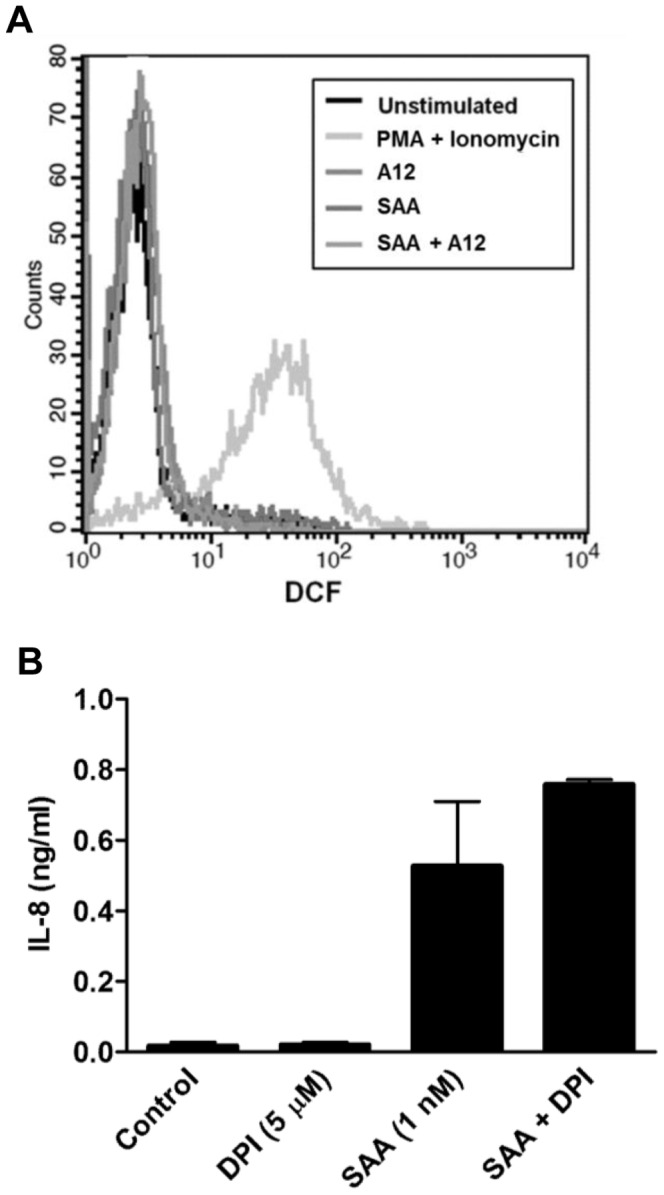
SAA at 1 nM had no effect on intracellular ROS levels.(A) Histogram from flow cytometric analysis of intracellular ROS levels in PBMC. The black line represents unstimulated cells; the different grey line profiles represent intracellular ROS levels, following treatments. PBMC were treated with SAA (1 nM), S100A12 (50 nM) or SAA+S100A12 for 30 min before ROS measurements. PMA+Ionomycin (10 µM) was included as positive control. Results from a single experiment, representative of two, are shown. (B) THP-1 cells were treated with DPI (5 µM), SAA (1 nM) or SAA+DPI, and levels of IL-8 in supernatants quantitated 15 h post-stimulation. Values are means ± SEM of duplicate assays from two separate experiments.